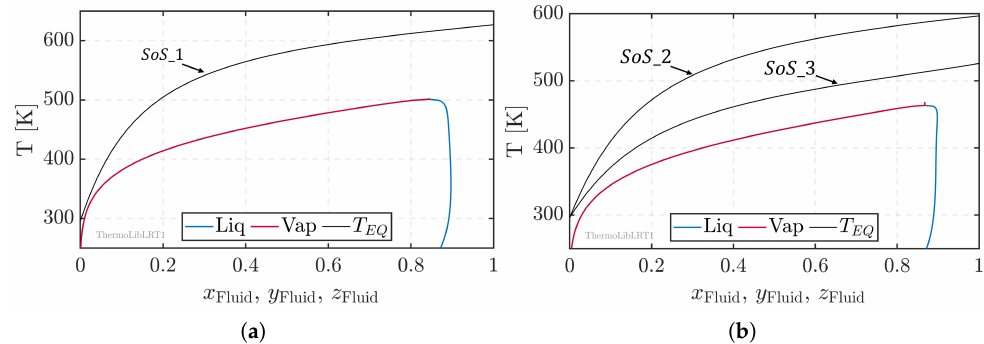
Figure 4. Temperature composition diagram for hexane/nitrogen ( SoS _1) in ( a ) and pentane/nitrogen ( SoS _2, SoS _3) in ( b ). The two-phase region, limited by the bubble-point line (blue) and dew-point line (red), is additionally indicated.